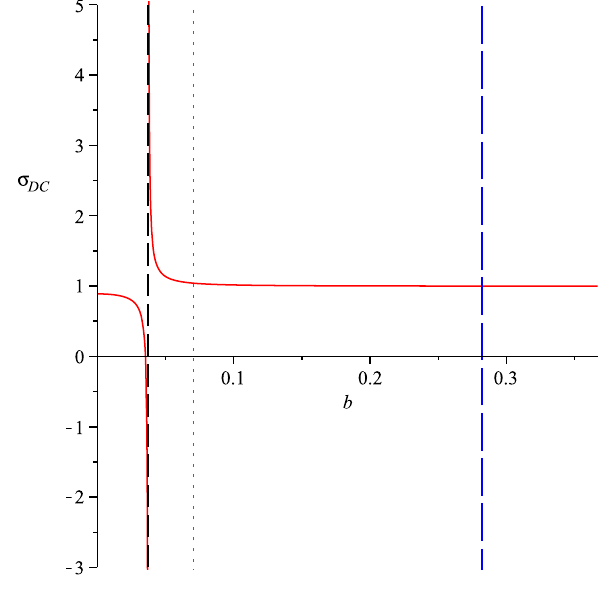
Fig. 2 σ DC vs b for any nonminimal couplings n < 0 or equivalently ξ > 1 4